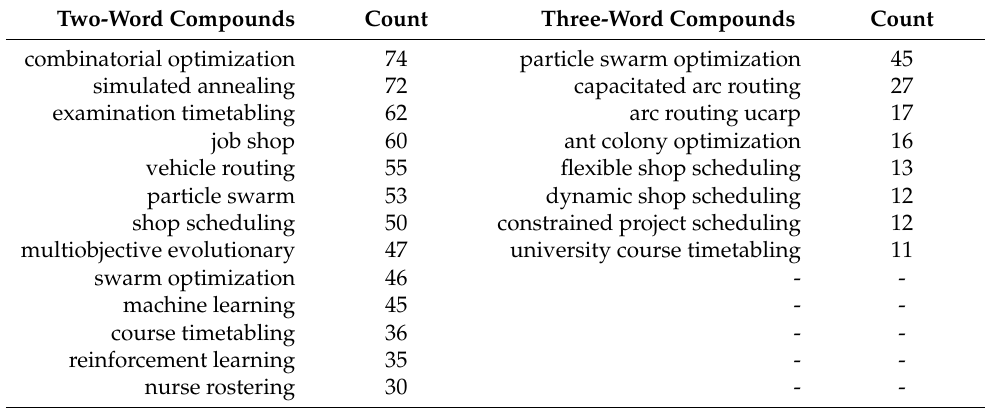
Table 1. Two- and three-word compound words from the abstracts of hyper-heuristic articles. Two-Word Compounds Count Three-Word Compounds Count combinatorial optimization 74 particle swarm optimization 45 simulated annealing 72 capacitated arc routing 27 examination timetabling 62 arc routing ucarp job shop 60 ant colony optimization vehicle routing flexible shop scheduling particle swarm dynamic shop scheduling shop scheduling constrained project scheduling multiobjective evolutionary swarm optimization machine